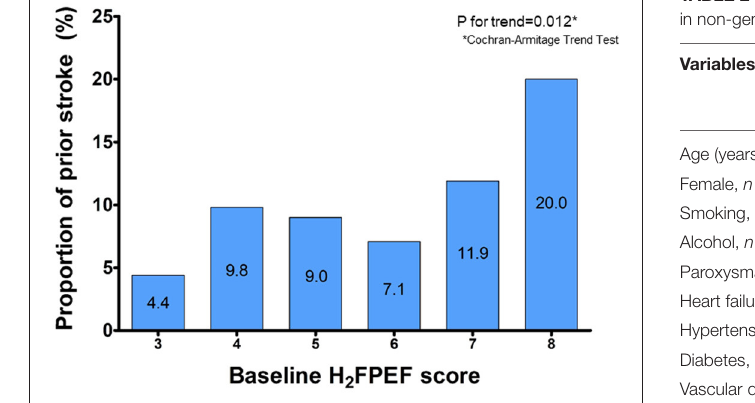
patients with previous stroke events, and 99 of them had a high risk for cardioembolism to the TOAST classification. About 84% of previous stroke events (95/113) had occurred within a year.